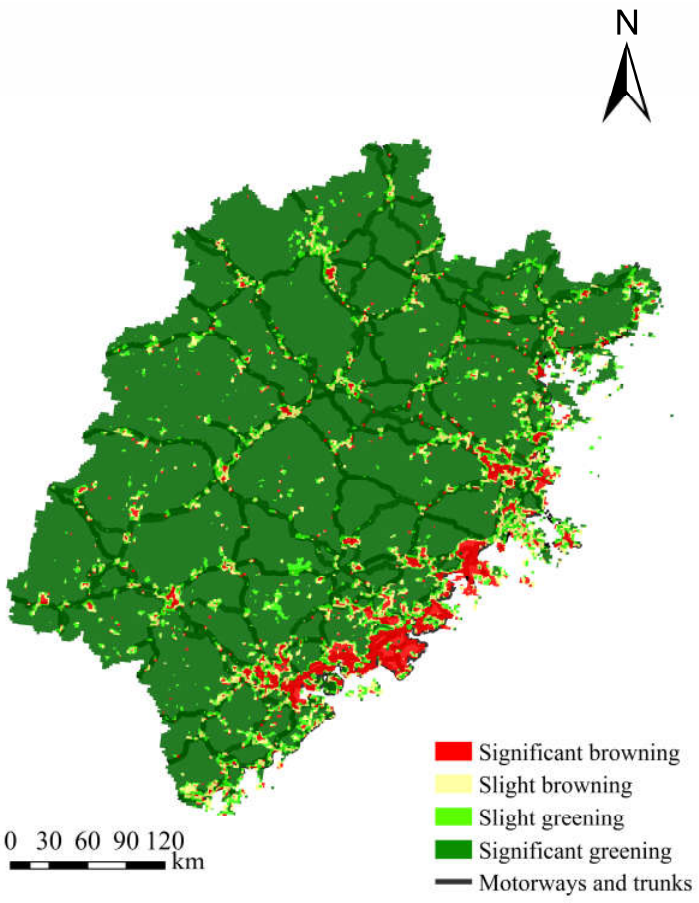
Figure 3. Spatial distribution of vegetation greening and browning from 1998 to 2018.